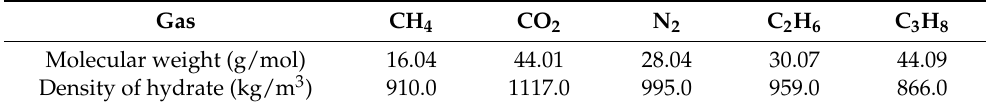
Table 2. The density of hydrates formed by typical pure gases (273.15 K). Gas CH 4 CO 2 N 2 C 2 H 6 C 3 H 8 Molecular weight (g/mol) 16.04 44.01 28.04 30.07 44.09 Density of hydrate (kg/m 3 ) 910.0 1117.0 995.0 959.0